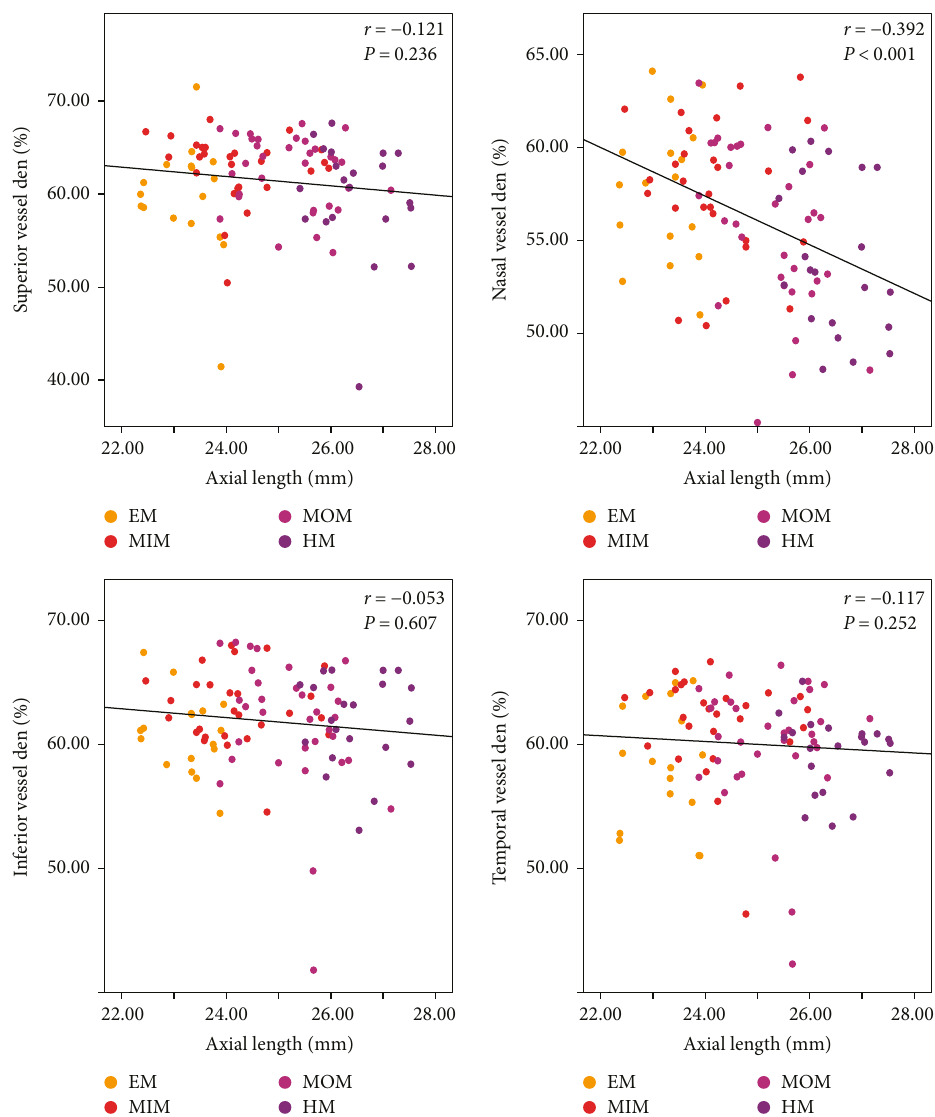
Figure 4: Scatterplots illustrating the linear (black line) associations between axial length (mm) and optical coherence tomography angiography (OCTA) peripapillary quadrant (superior, nasal, inferior, and temporal) vessel density (%) measurement of the studied eyes. r , correlation coe ffi cient from the Spearman rank correlation analysis; EM, emmetropia, MSE 0.50 D to − 0.50D; MIM, mild myopia, MSE − 0.75 D to − 2.75D; MOM, moderate myopia, MSE − 3.00D to − 5.75D; HM, high myopia, MSE ≤−